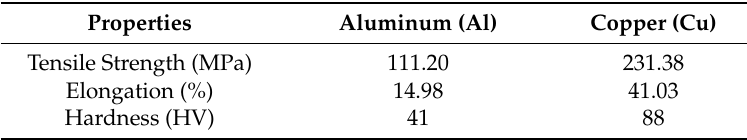
Table 1. Mechanical properties of Al and Cu.